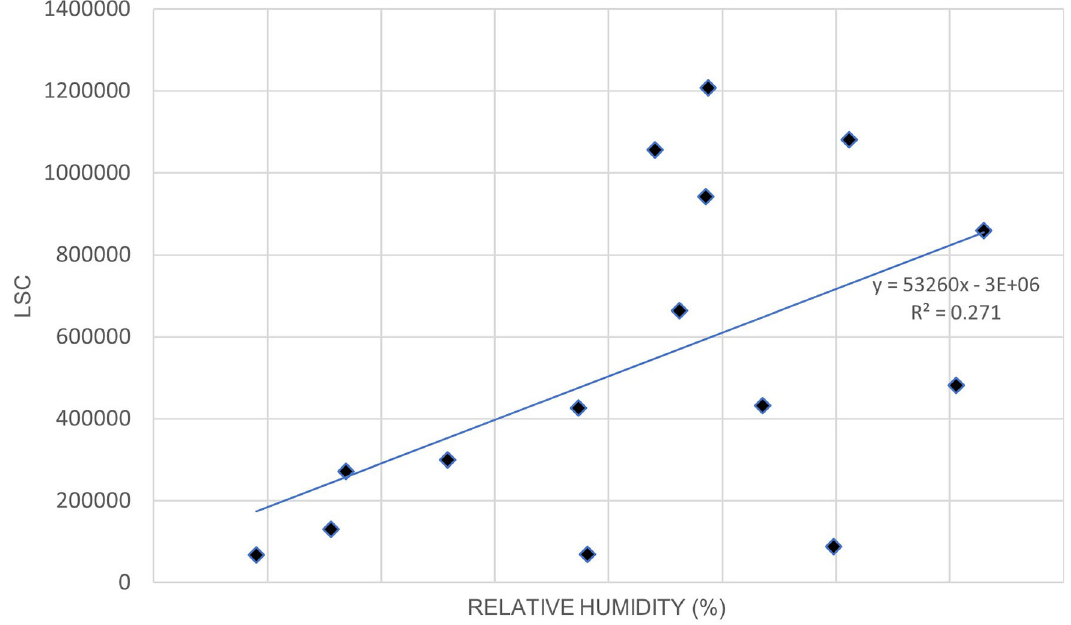
Figure 3. LSC vs relative humidity over Europe during March to July 2020.